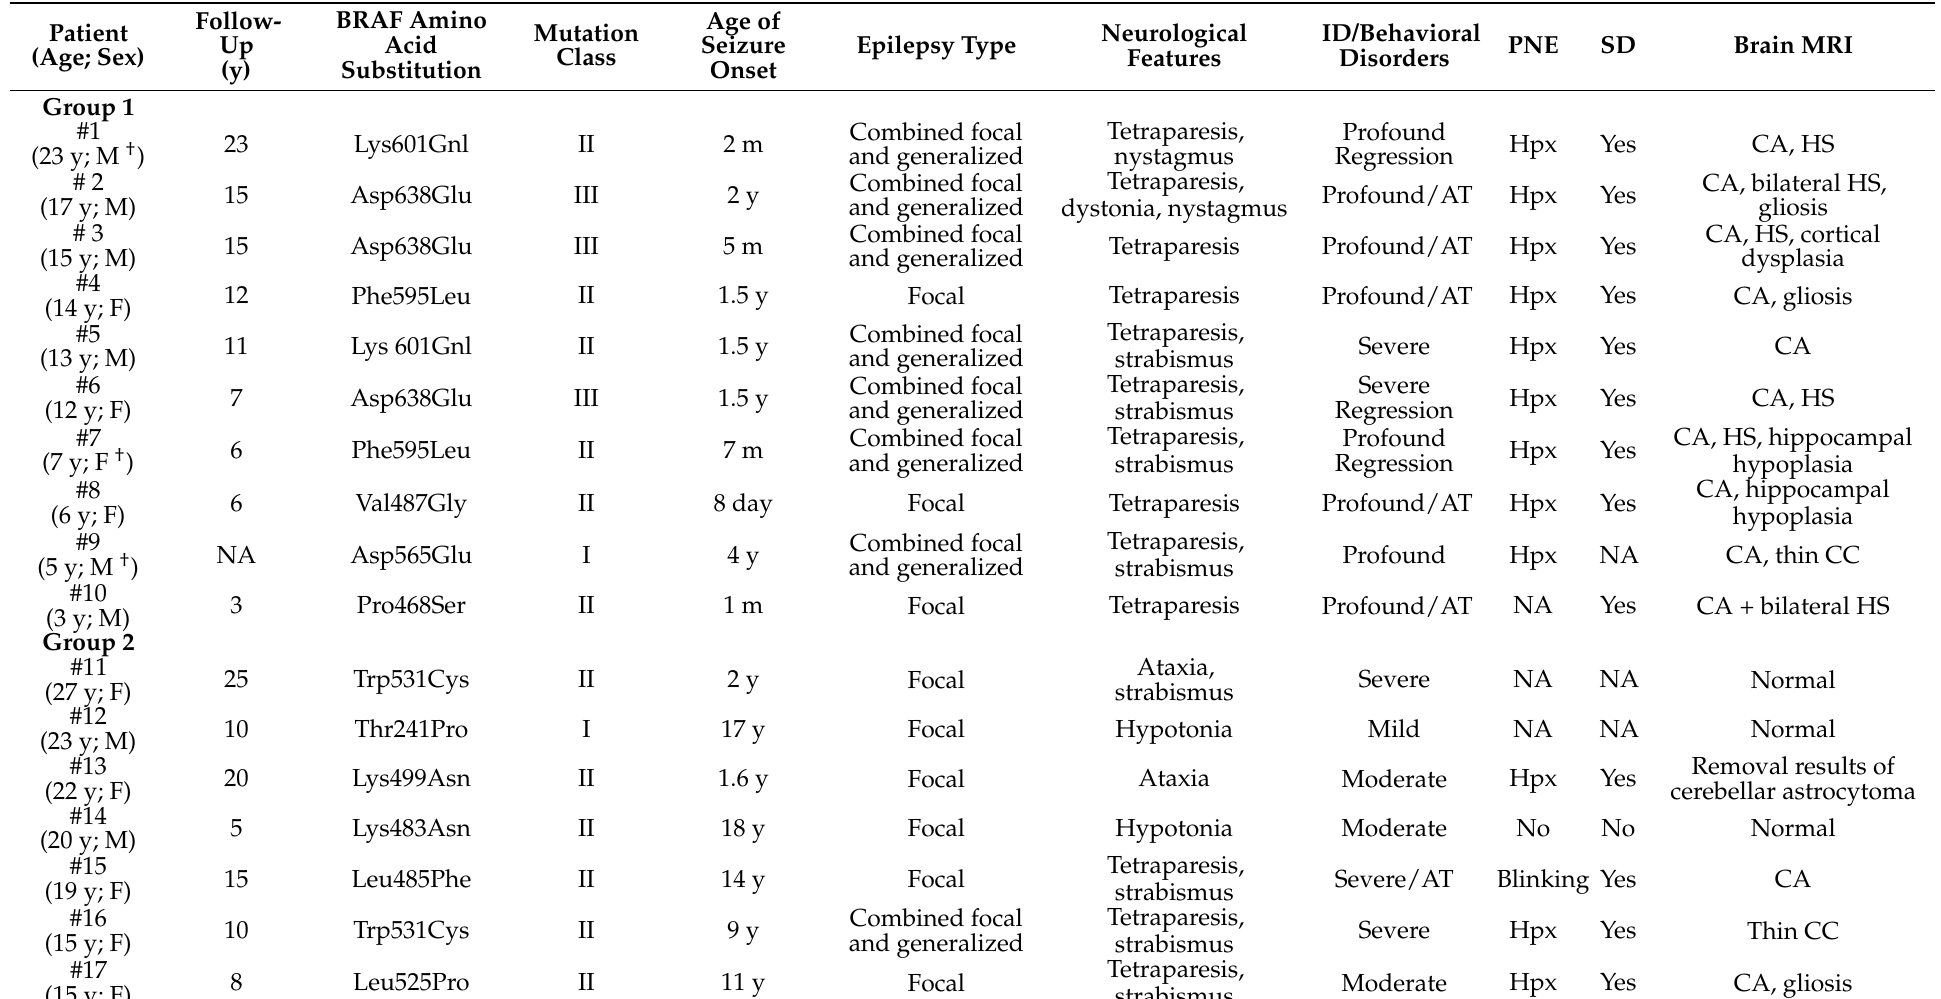
Table 1. Demographic, genetic and clinical characterization of the study